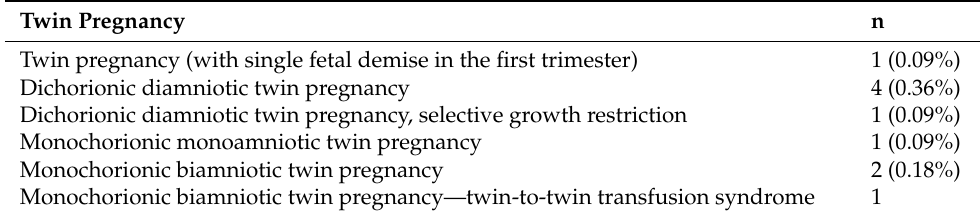
Table 4. Types and complications of twin pregnancies.